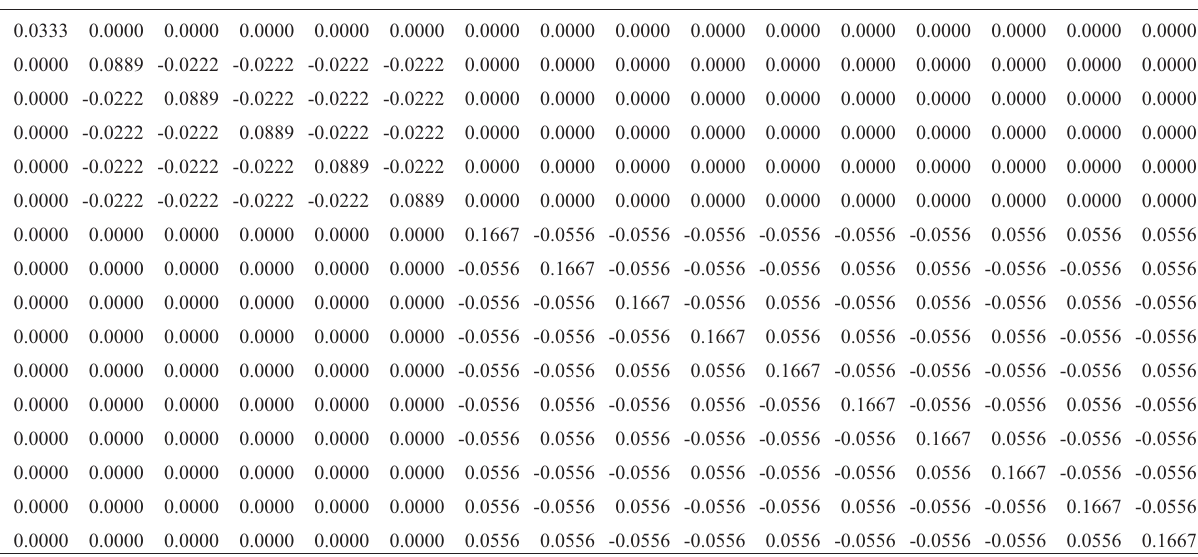
Table 9 - Estimates of the variances and covariances of the effects for a complete diallel model calculated using a matrix